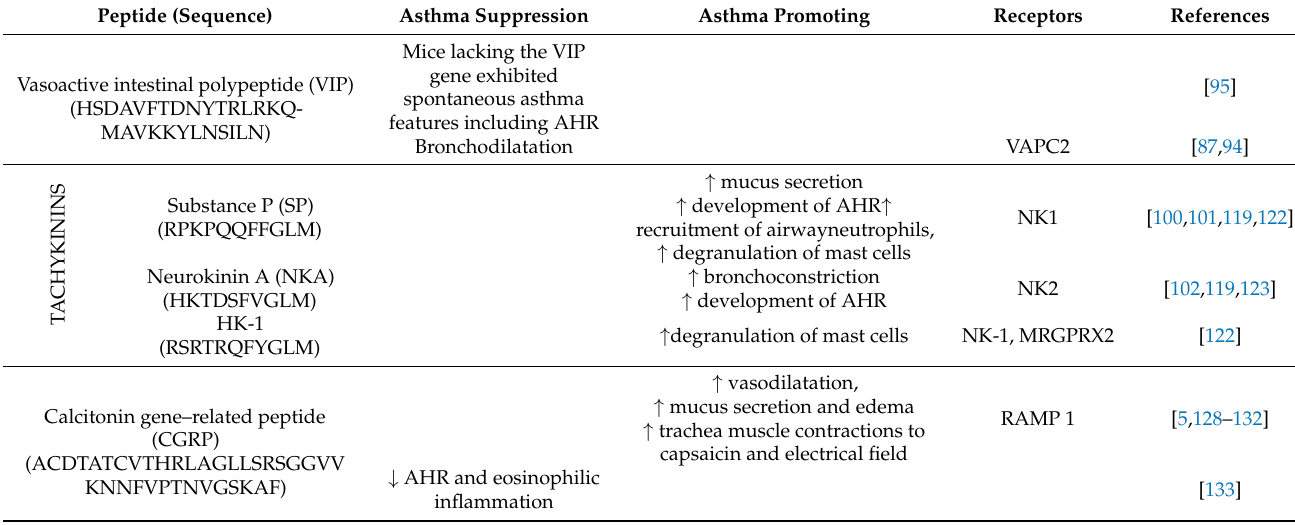
Table 3. Neuropeptides released by vagus efferents (i-NANC, e-NANC) and retrogradely released by afferents (capsaicin C-fibers) contributing to asthma symptoms. A description of the action of a particular peptide and its receptor involved. Peptide (Sequence) Vasoactive intestinal polypeptide (VIP)